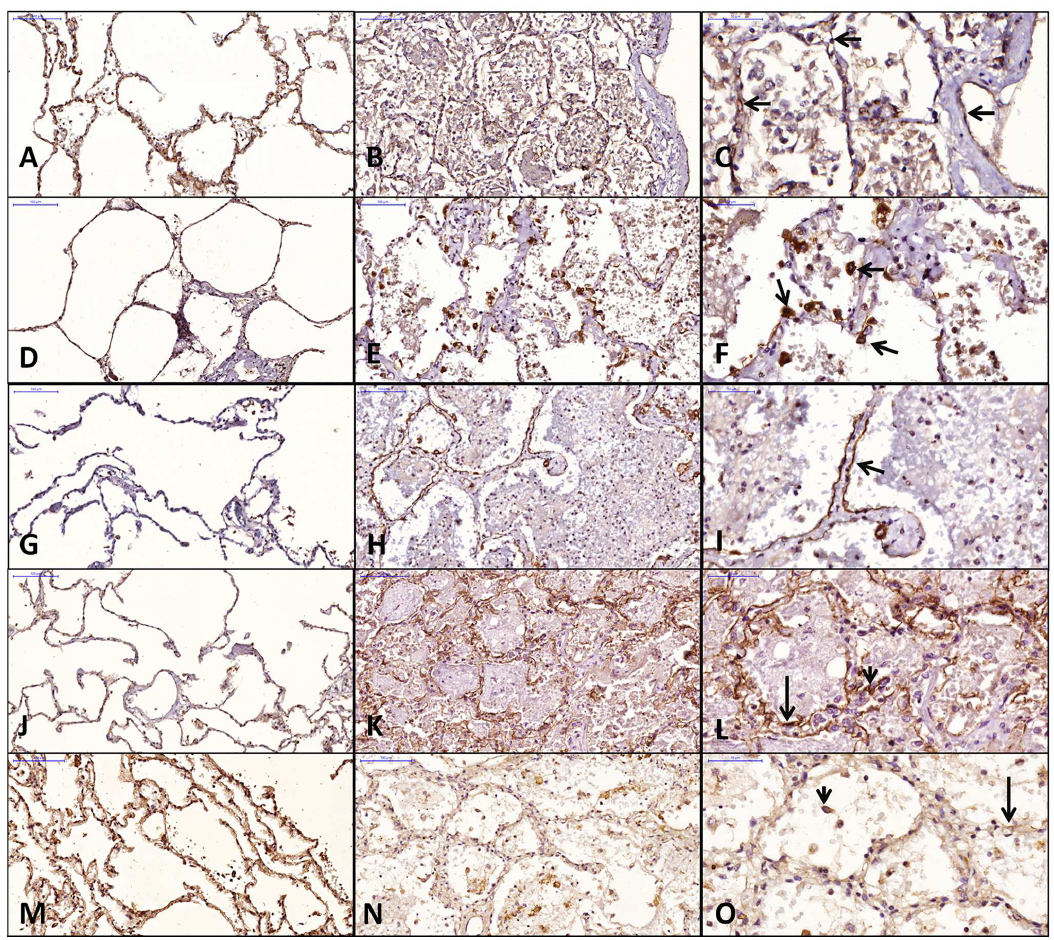
Fig 4. Representative histological images of aquaporins and ion channels expression in DAD and control groups. A, D, G, J and M: control; B, E, H, K and N: DAD; C, F, I, L and O: DAD, highermagnification. AQP 1: A, B, C; AQP 3: D, E, F; AQP 5: G, H, I; Na-K-ATPase: J, K, L; ENaC: M, N, O. C: AQP1 in endothelialcells (arrows); F: AQP3 in PII cels (arrows); I: AQP5 in PI cells (arrow); L: Na-K-ATPase in PI cell (long arrow) and PII cell (short arrow); O: ENaC in PI cell (long arrow) and PII cell (short arrow).